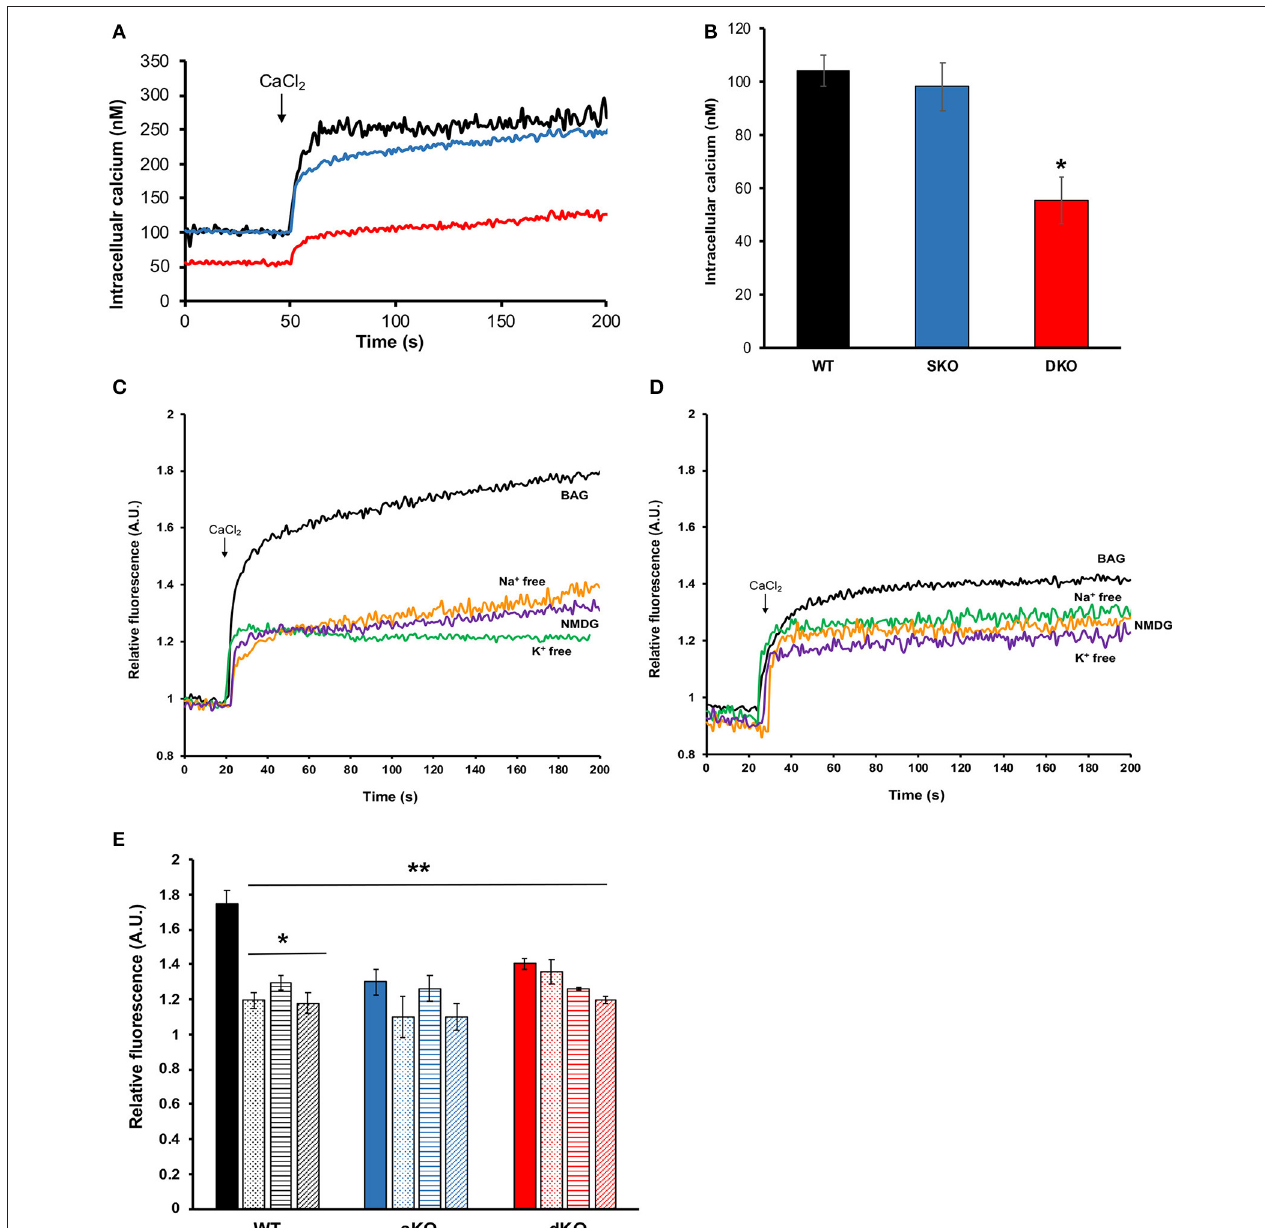
FIGURE 7 | Intracellular calcium measurements. (A) Representative traces of Fura-2 AM loaded epimastigotes showing intracellular calcium concentrations for WT (black trace), sKO (blue trace) or dKO (red trace) in BAG. At 50s of recording, 1.8mM CaCl 2 was added to the extracellular buffer. (B) Quantification of baseline intracellular calcium in BAG prior to extracellular calcium addition. Values are Mean ± SD of 5 independent experiments. * p < 0.05 compared with WT. (C,D) Representative traces of intracellular calcium measurements (in relative fluorescence units for comparison purposes) of WT (C) and TcCAKS dKO (D) , in the indicated buffer conditions. (E) Intracellular calcium changes (in relative units) upon CaCl 2 addition in WT (black), sKO (blue), and dKO (red) epimastigotes in BAG (solid bars), Na + free (dotted bars), K + free (horizontal stripe bars) or NMDG buffer (striped bars). Values are Mean ± SD of 5 independent experiments. * p < 0.05 compared with BAG, ** p < of each condition and strain compared with WT in BAG. Statistical analysis for multiple conditions was done by two-way ANOVA with post-hoc Bonferroni correction.